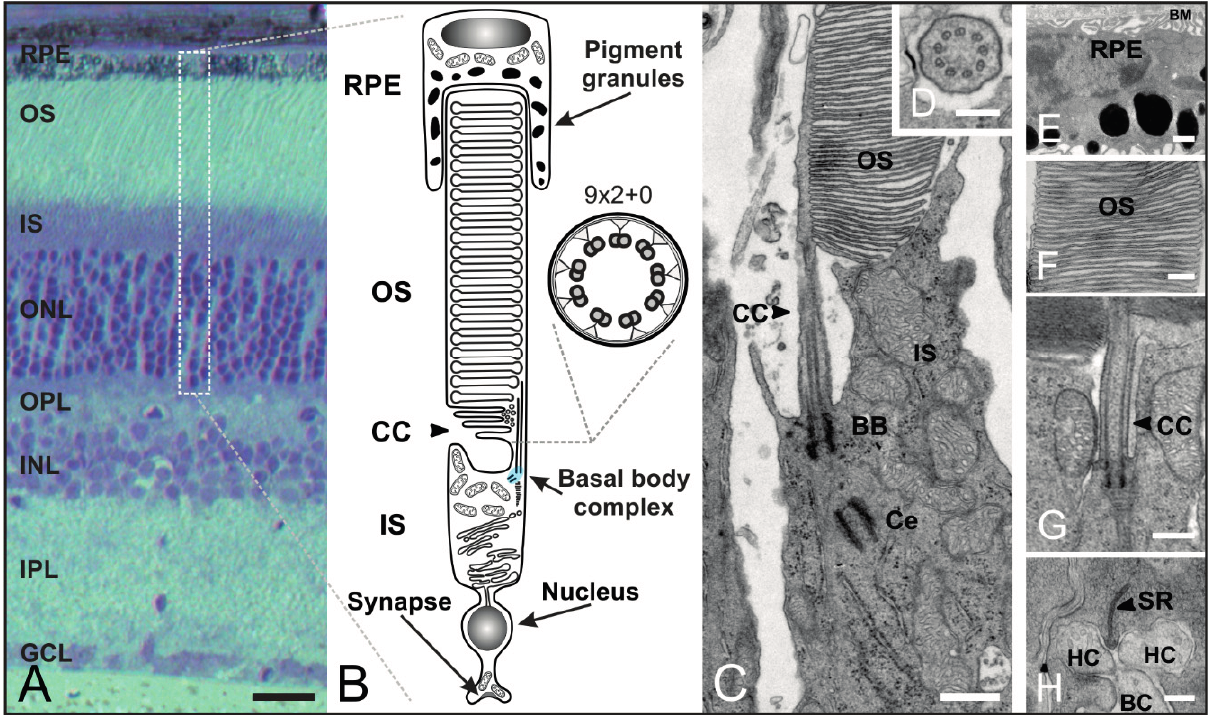
Figure 5. Organization of rod photoreceptors in the mammalian retina. ( A ) Vertical section of a vertebrate retina stained with toluidine blue. The retina contains five classes of neurons (photoreceptors, bipolar cells, horizontal cells, amacrine cells, ganglion cells), and is divided into three nuclear layers (outer nuclear layer (ONL), inner nuclear layer (INL), ganglion cell layer (GCL)) and two synaptic layers (outer plexiform layer (OPL), inner plexiform layer (IPL)); ( B ) Schematic of a vertebrate rod photoreceptor consisting of the long, light-sensitive outer segment (OS) enclosed by the retinal pigment epithelium (RPE) which is connected via a small intracellular bridge, the connecting cilium (CC), to the metabolically active inner segment (IS) including the basal body complex (BBC; shaded in blue) and the apical region. The OS represents a modified primary cilium. The CC corresponds to the transition zone of a prototypic cilium with a (9 × 2 + 0) microtubule array; ( C – H ) Transmission electron micrograph of a photoreceptor-connecting cilium; ( C ) The CC connects the OS and IS. The BBC consists of the basal body (BB) and its centriole (Ce); ( D ) Cross-section of the CC showing the characteristic (9 × 2 + 0) microtubule array; ( E ) RPE with pigment granules and the Bruch’s membrane (BM); ( F ) OS composed of stacks of tightly packed membrane discs; ( G ) Higher magnification view of the ciliary apparatus; ( H ) Synaptic ribbon (SR) with invaginations of postsynaptic horizontal cells (HC) and bipolar cells (BC). Scale bars: 100 µm ( A ), 200 nm ( D , F , H ), 500 nm ( E , G